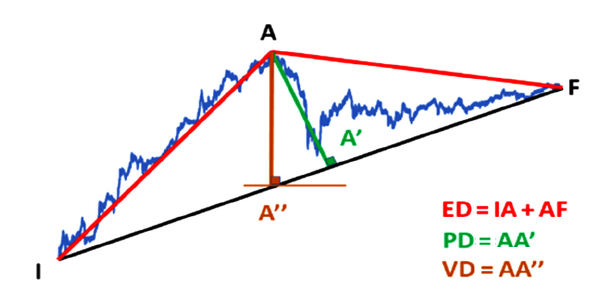
Figure 5. Defining Perceptual Important Points (PIPs) (source: own processing)